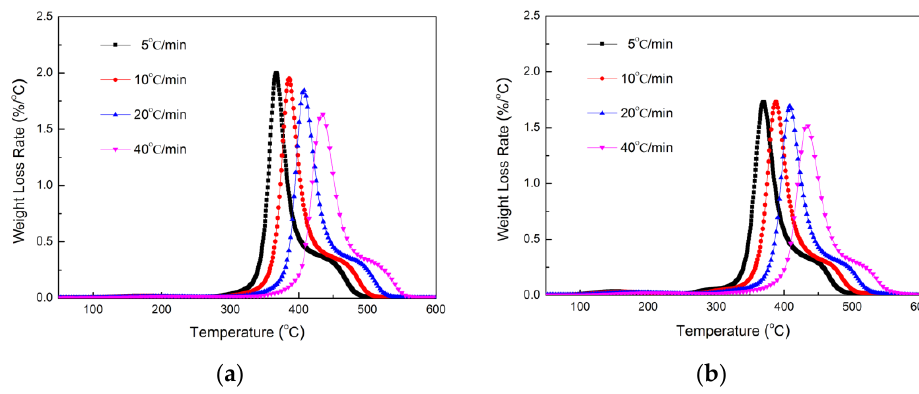
Figure 5. DTG curves of TE ( a ) and FRTE ( b ) composites.